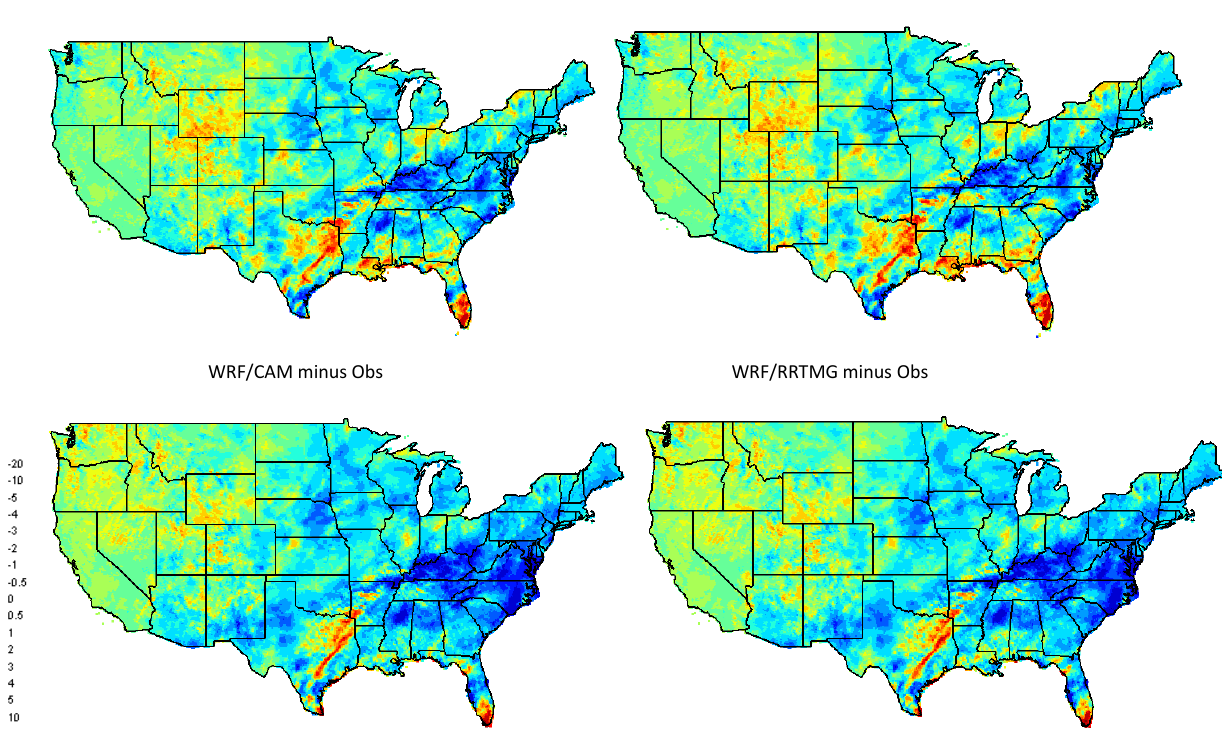
Figure 25. Same as Fig. 24, but for September of 2006.